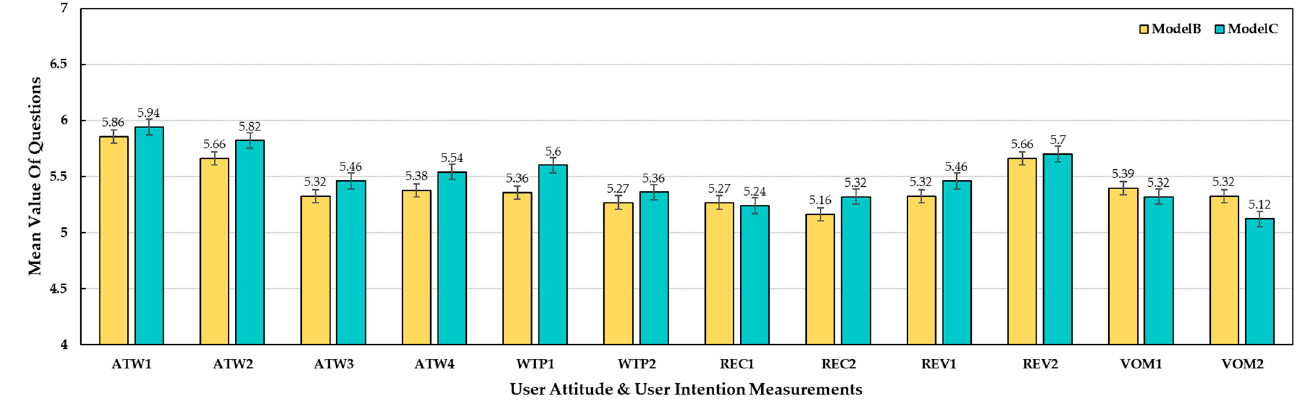
Figure 7. Website quality comparison between Model B and Model C.